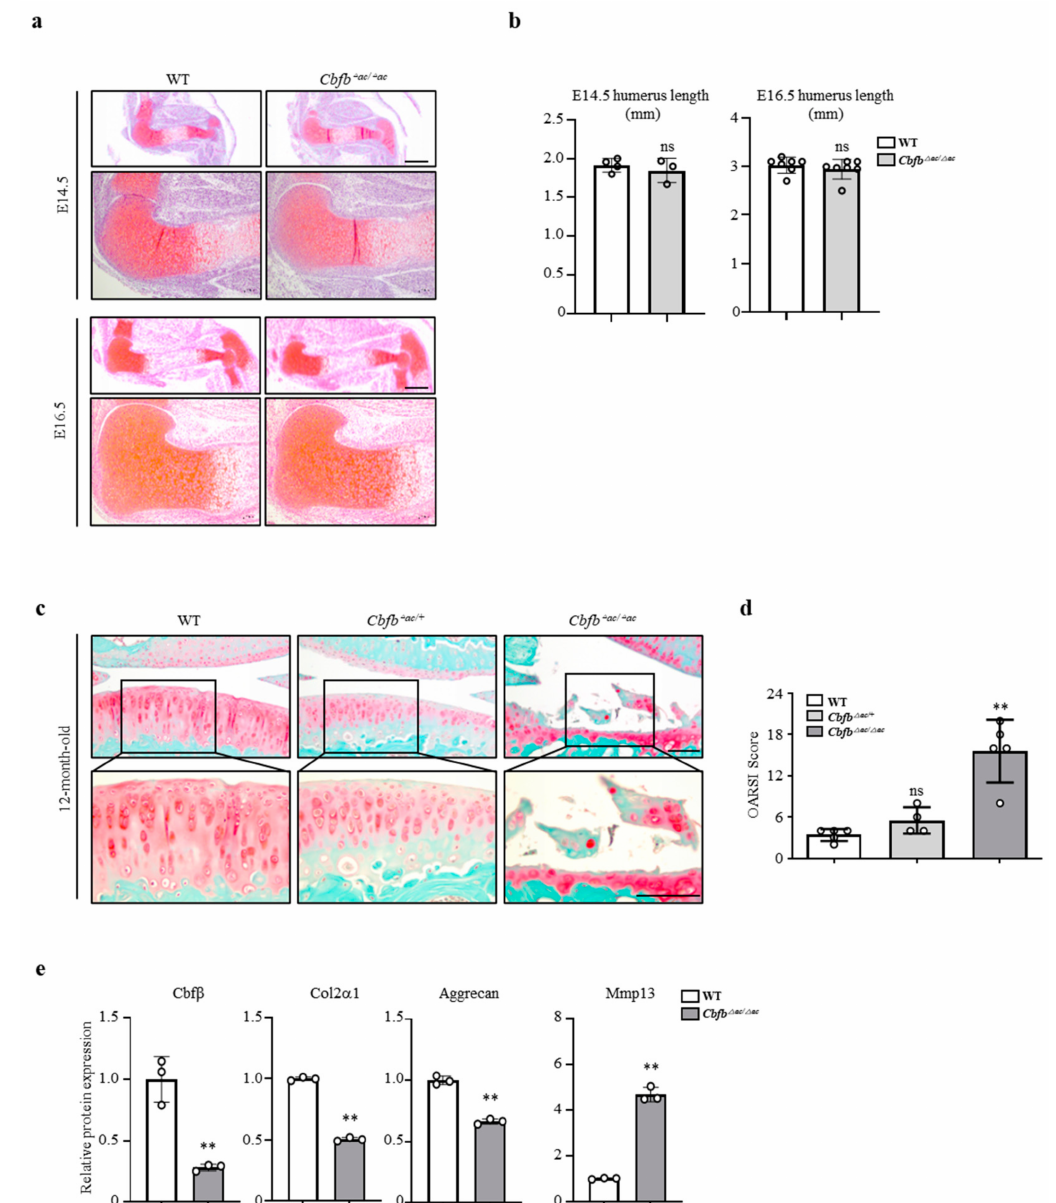
Figure 2. Articular-cartilage-specific Cbf β -deleted mice exhibit spontaneous cartilage degener- ation. ( a , b ) Evaluation of joint and limb formation via Safranin-O staining at E14.5 (WT = 4, Cbfb ∆ ac/ ∆ ac =3) and E16.5 (WT = 7, Cbfb ∆ ac/ ∆ ac = 7) of Cbfb ∆ ac/ ∆ ac mice. The humerus length was analyzed with the Leica program. Scale bars, 500 µ m and 100 µ m. ( c ) Spontaneous OA development assessed via Safranin O staining in 12-month-old Cbfb ∆ ac/ ∆ ac mice. ( d ) OA severity was determined by histological analysis according to OARSI guidelines. Scale bars, 100 µ m (WT = 5, Cbfb ∆ ac/ ∆ ac = 4, Cbfb ∆ ac/ ∆ ac = 5). ** p < 0.01 vs. WT. ( e ) Cbf β , Col2 α 1, Aggrecan, and Mmp13 mRNA expression were evaluated using qRT-PCR in 12-month-old Cbfb ∆ ac/ ∆ ac articular cartilage. ** p < 0.01 vs. WT, ns not